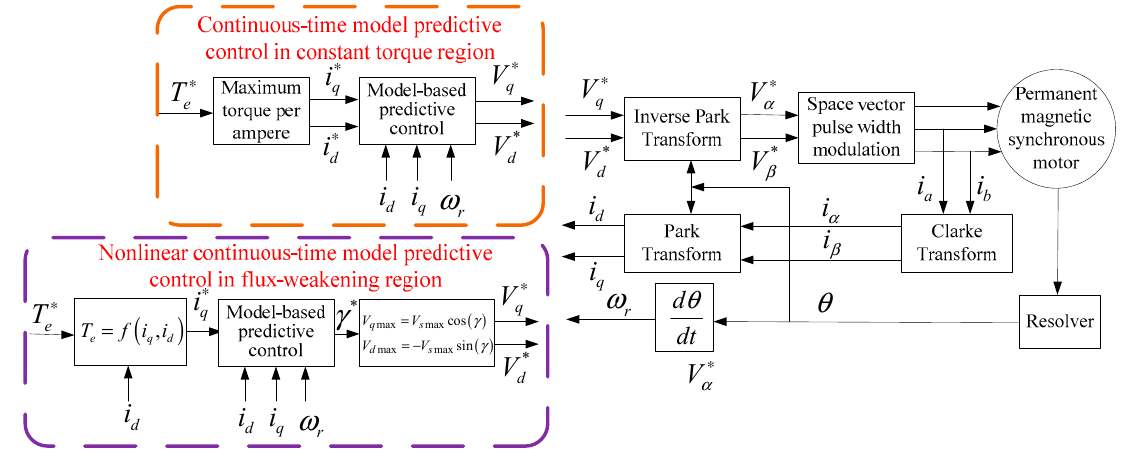
Figure 1. Block diagram of the proposed control system for a wide-speed range.